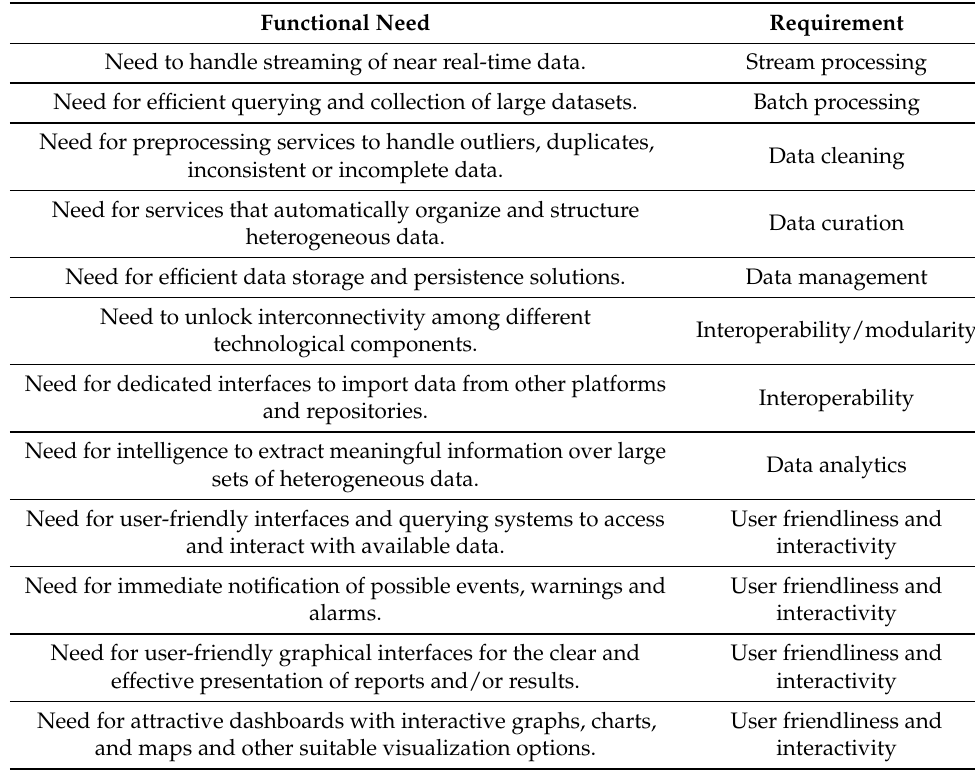
Table 2. Main functional requirements for smart building use